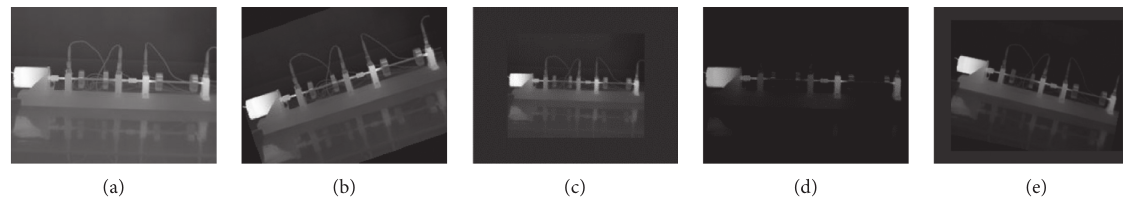
Figure 3: Infrared image enhancement. (a) Original. (b) Rotating. (c) Scaling. (d) Brightness adjustment. (e) Mixed